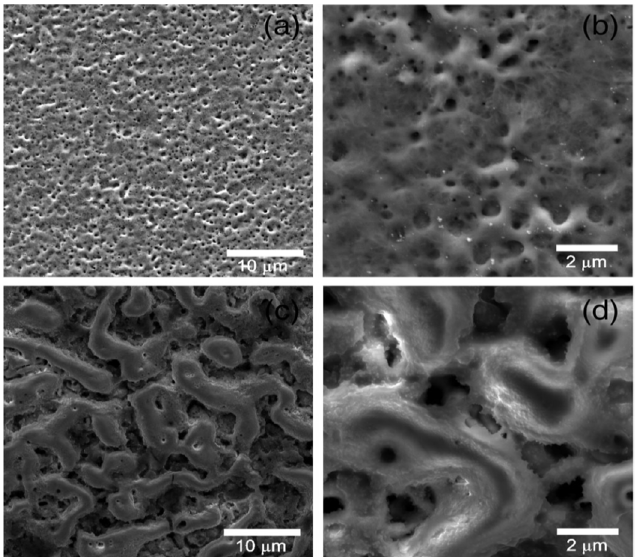
Figure 14. Surface morphology of ( a , b ) microcrystalline Ta and ( c , d ) nanocrystalline Ta after MAO treatment. Reproduced with permission from Ref. [75]. Copyright 2020 John Wiley and Sons.